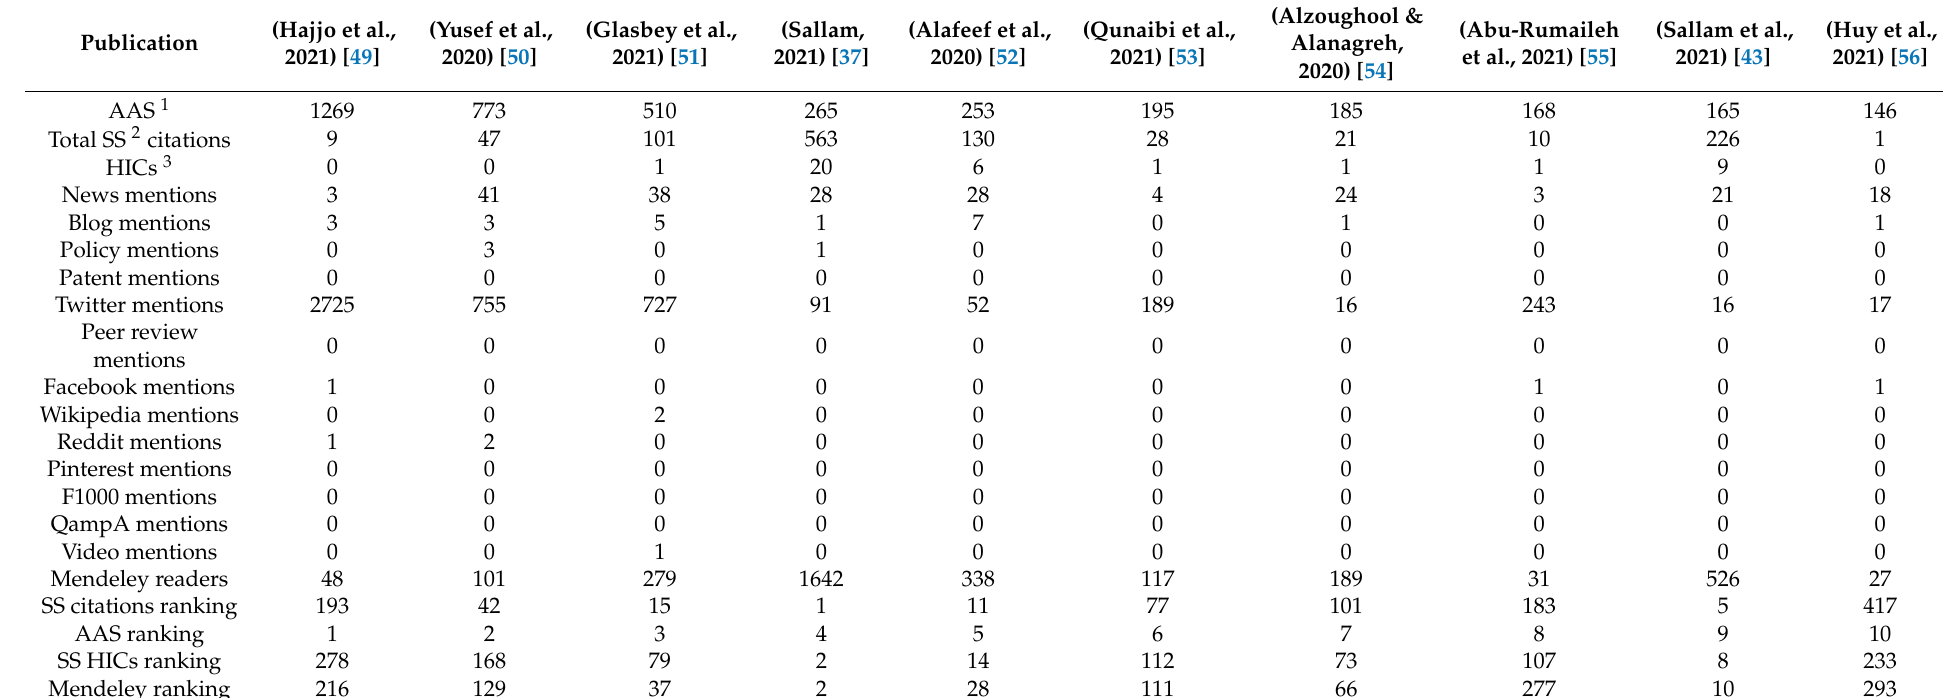
Table 4. Characteristics of the top 10 COVID-19 related papers in the study in terms of Altmetric Attention Score